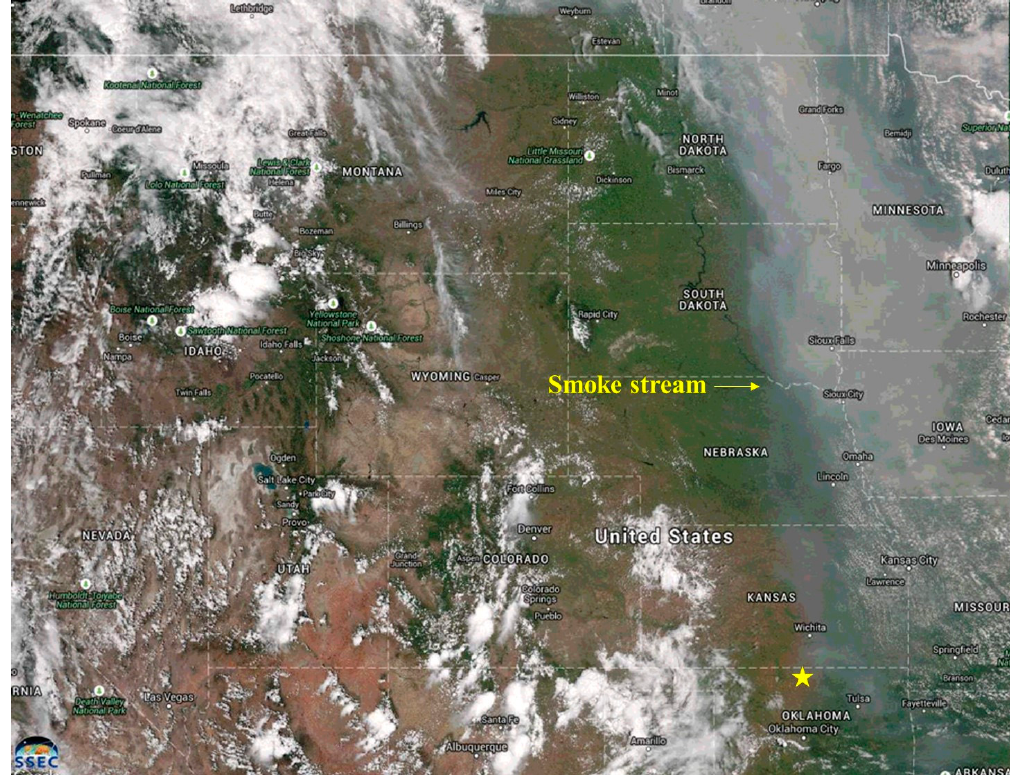
Figure A2. The true-color red–green–blue (RGB) imagery of VIIRS (Visible Infrared Imaging Radiometer Suite) onboard the SNPP (Suomi National Polar-orbiting Partnership) at 20:13 UTC on the first day (as marked red dashed line in Figure A3). Ashy smoke stream is seen across the central part of North America. The ARM SGP site (marked with a yellow star) is located at the edge of the smoke stream (image source: http://cimss.ssec.wisc.edu/goes/blog/wp-content/uploads/2015/06/150629_